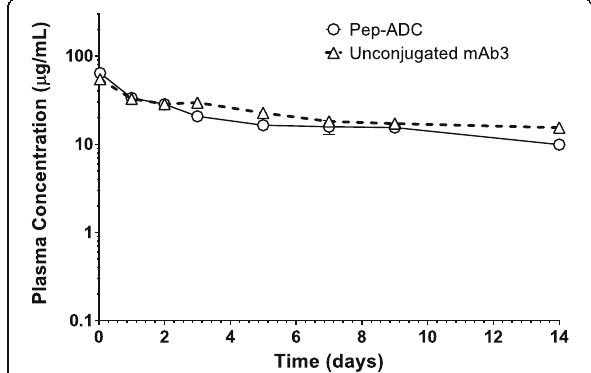
Fig. 12 The concentration time profiles of Pep-ADC and unconjugated mAb3. Plasma was collected at indicated time points over 14 days following a single 3 mg/kg IV administration of DyLight 650-labeled Pep-ADC or DyLight 650-labeled unconjugated mAb3 in normal C57BL/6 J mice, and the concentrations were determined by fluorescence emission-linked assays. Data plotted are mean from two mice per time point. Error bars correspond to the range. Error bars smaller than the symbols are not plotted